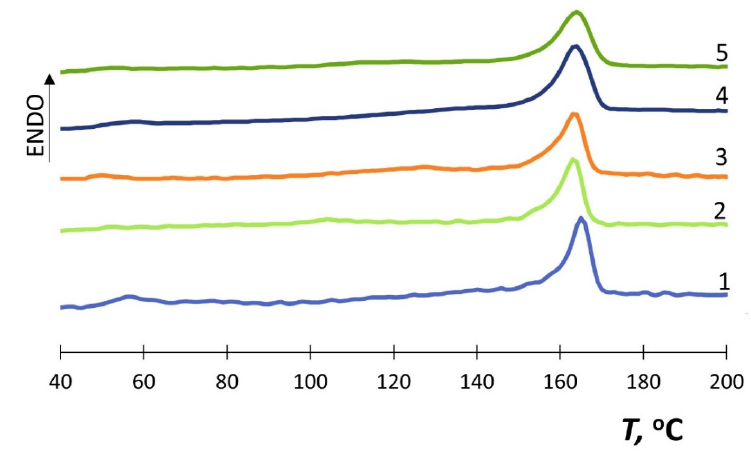
Figure 4. DSC thermograms of PLA (1) and composites PLA–TPP4OC 6 with TPP4OC 6 content, wt.%: 0.2 (2), 0.3 (3), 0.4 (4), and 0.5 (5).